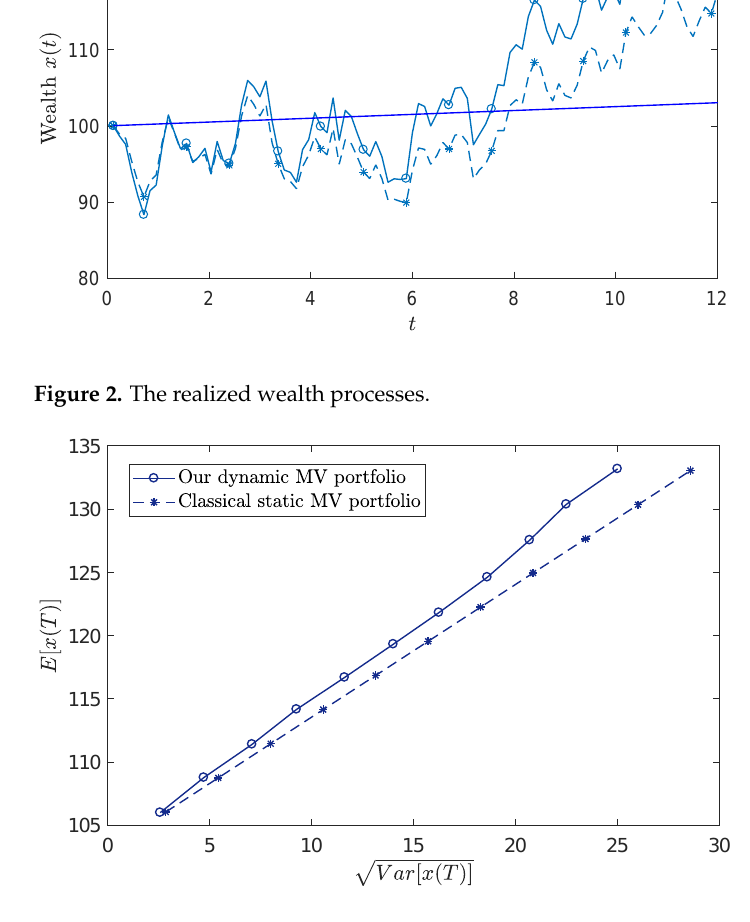
Figure 3. The efficient